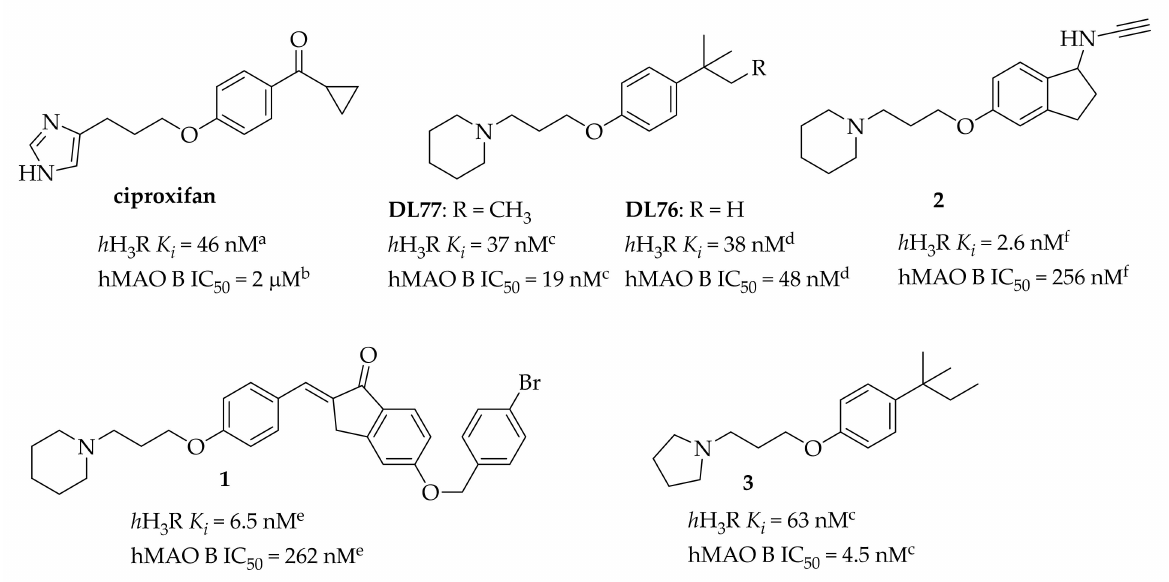
Figure 1. Structures of DTL–histamine H 3 receptor ligands with MAO B inhibitory activity. a : data from Ref. [9]; b : from [8]; c : from [6]; d : from [7]; e : from [4]; f : from